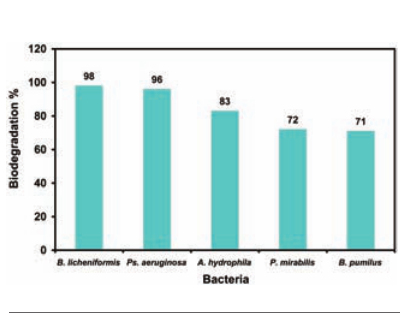
Figure 3. Percent biodegradation of dimethoate by five bacterial isolates.